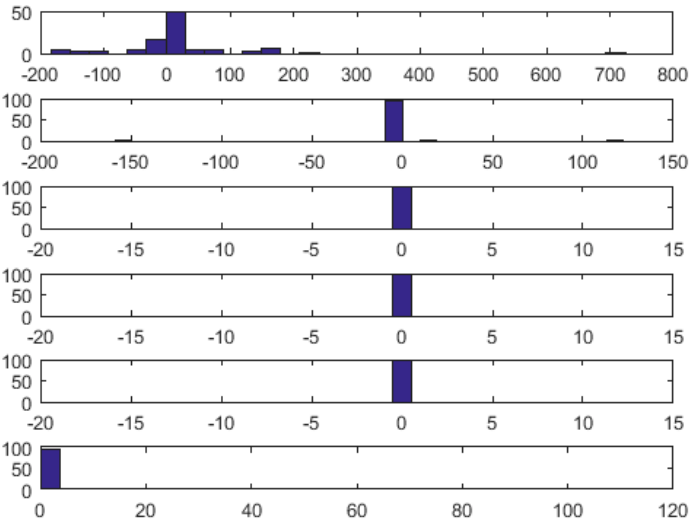
Figure 7. Histograms of QRS length error distribution for db5 wavelet and n = {1...5} bit depth watermark coding (top to bottom); the lowest plot shows the automatic adjustment of coding bit depth.